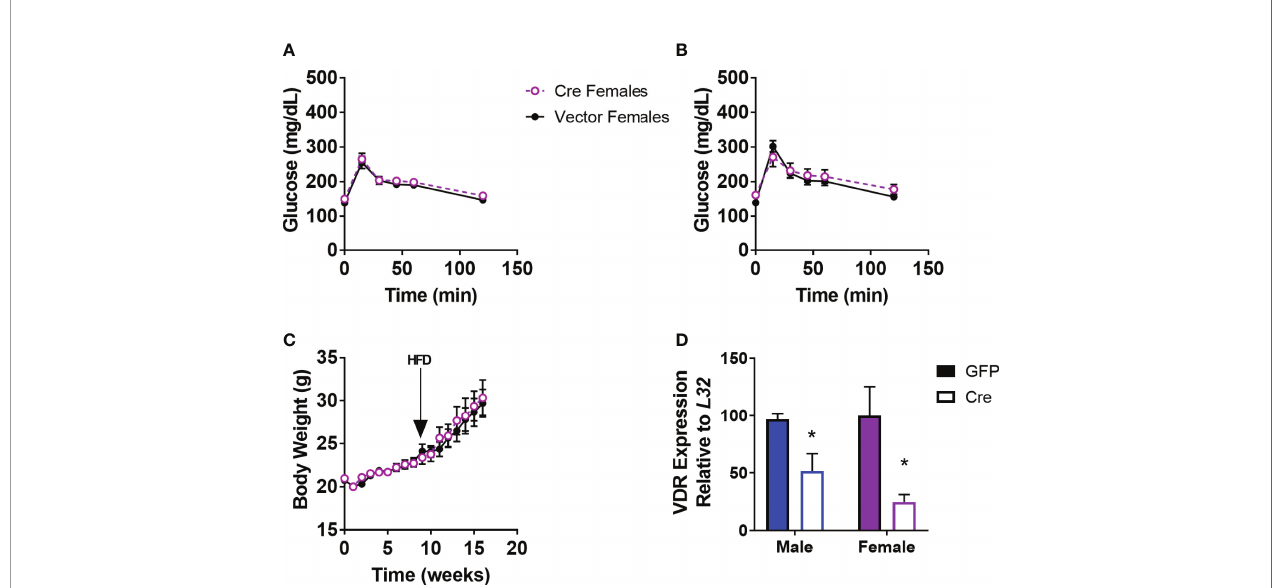
FIGURE 1 | Viral Knockdown of VDR in the PVH of females does not alter body weight or glucose tolerance. (A) Glucose tolerance test in lean female mice (16-20 weeks of age) after AAV-control or AAV-Cre bilateral administration into the PVH (1.5g/kg). (B) Glucose tolerance test (1.5 g/kg) in 24-28 week old DIO mice. (C) Body weight trajectories of female mice after virus administration. HFD = start of high-fat diet to induce obesity. (D) VDR expression in the PVH in male mice (previously published) and females. n = 7-8/gp for (C, D) and 3-4/gp for (D) *p<0.05.